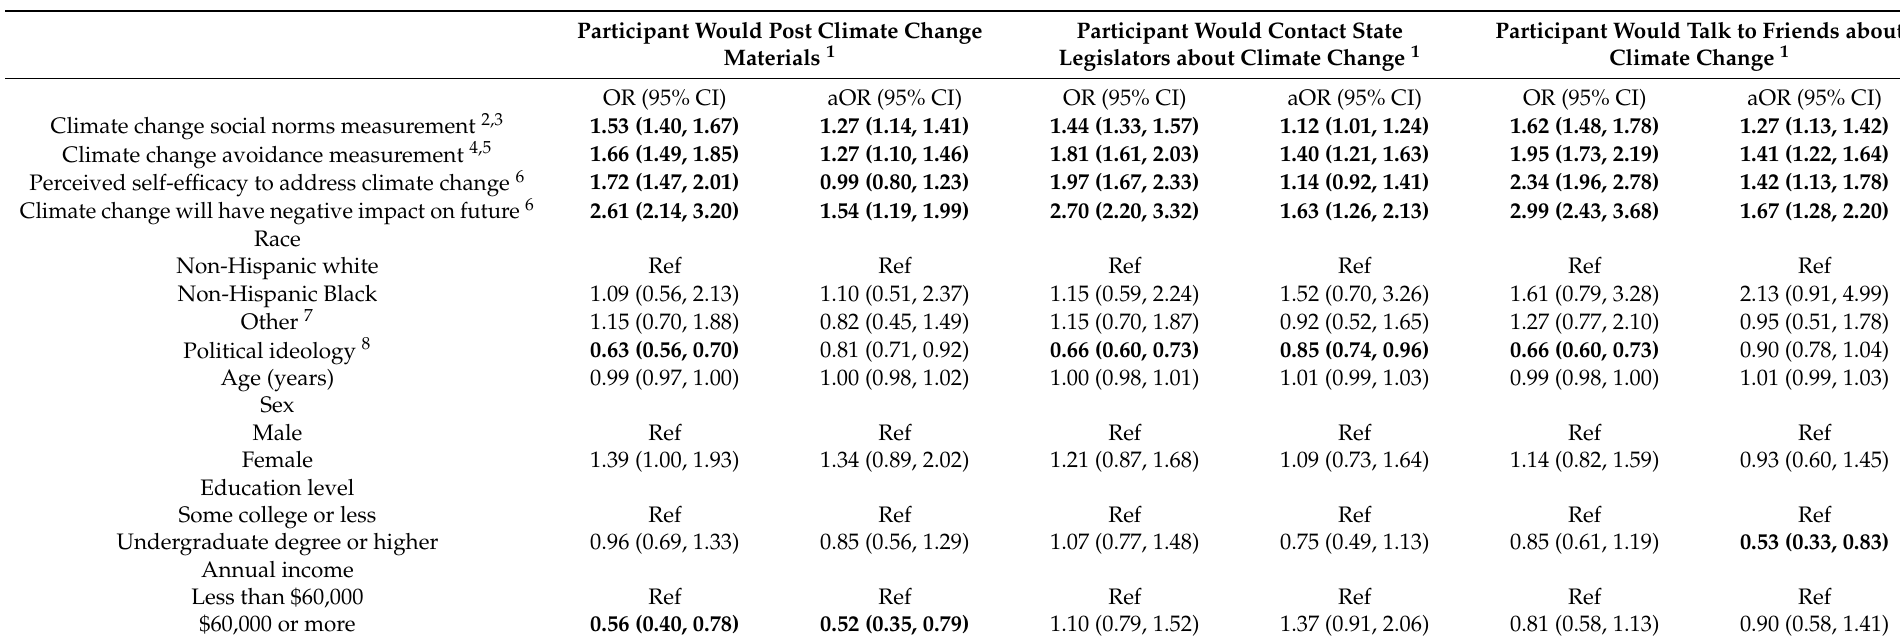
Table 2. Predictors of 3 Forms of Climate Change Communication Behaviors from 586 Participants who completed the MTurk Surveys at Waves 1, and